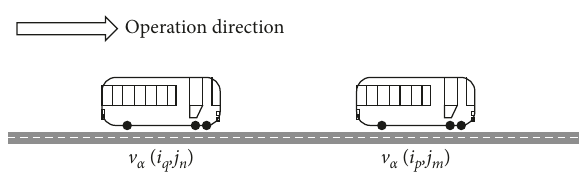
Figure 2: Diagram of vehicle serial